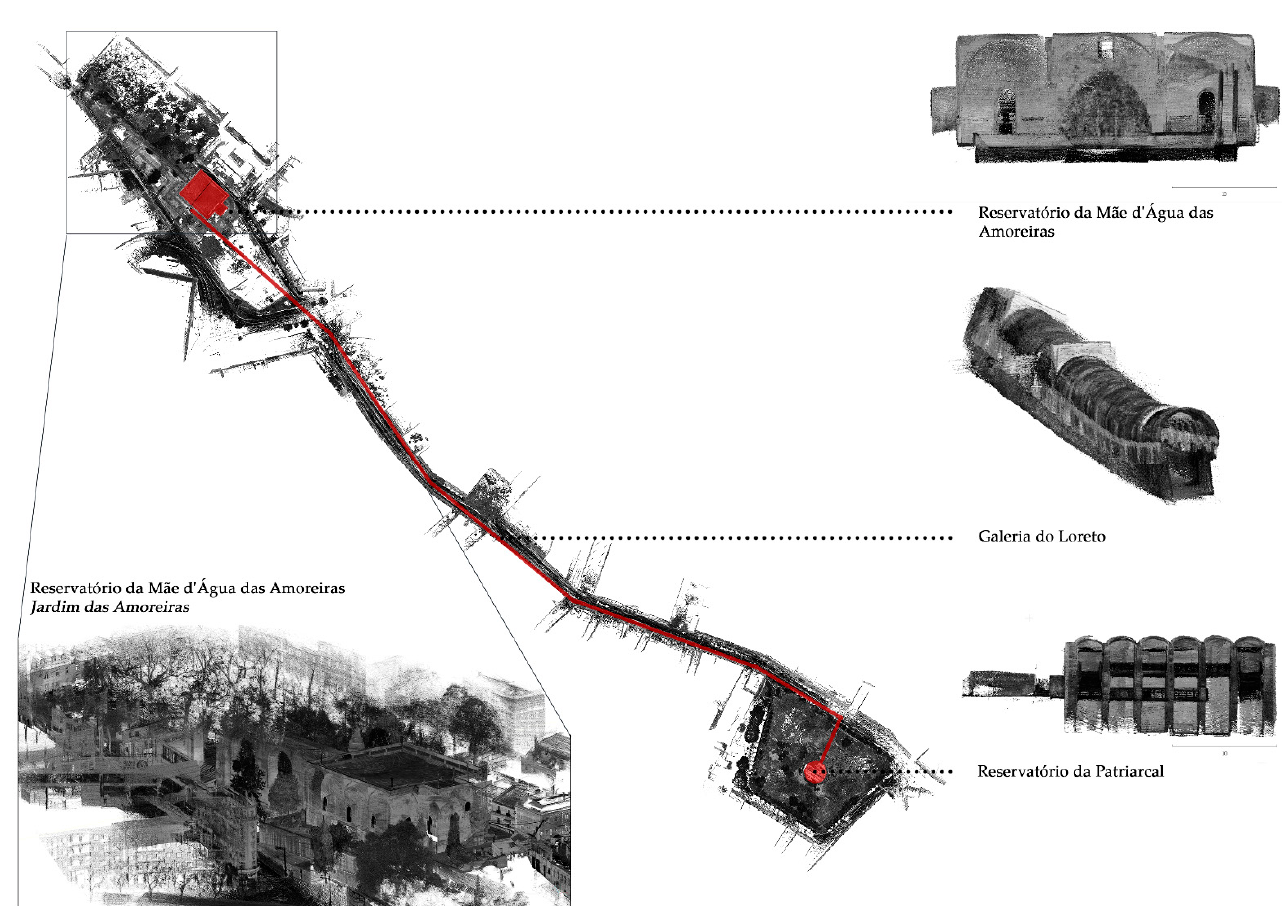
Figure 6. Overall view of point clouds (aligned) and sections of underground parts. Laser scanner survey was accompanied by photographic acquisition of the entire route. The Nikon D5500 [44] camera was used to capture 800 images covering the three surveyed areas (Figure 7), and the use of the Nikon KeyMission 360 [45] made it possible to acquire video and spherical photos of the points of interest (Figure 8).